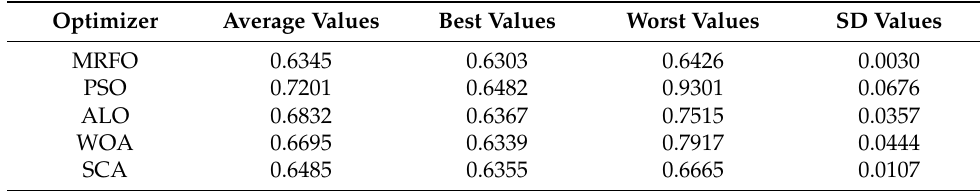
Figure 25. Bus voltage magnitudes of the 15-bus system with RERs. Table 10. The 15-bus system simulation results. Table 11. The statistical results in the 15-bus system with the use of several